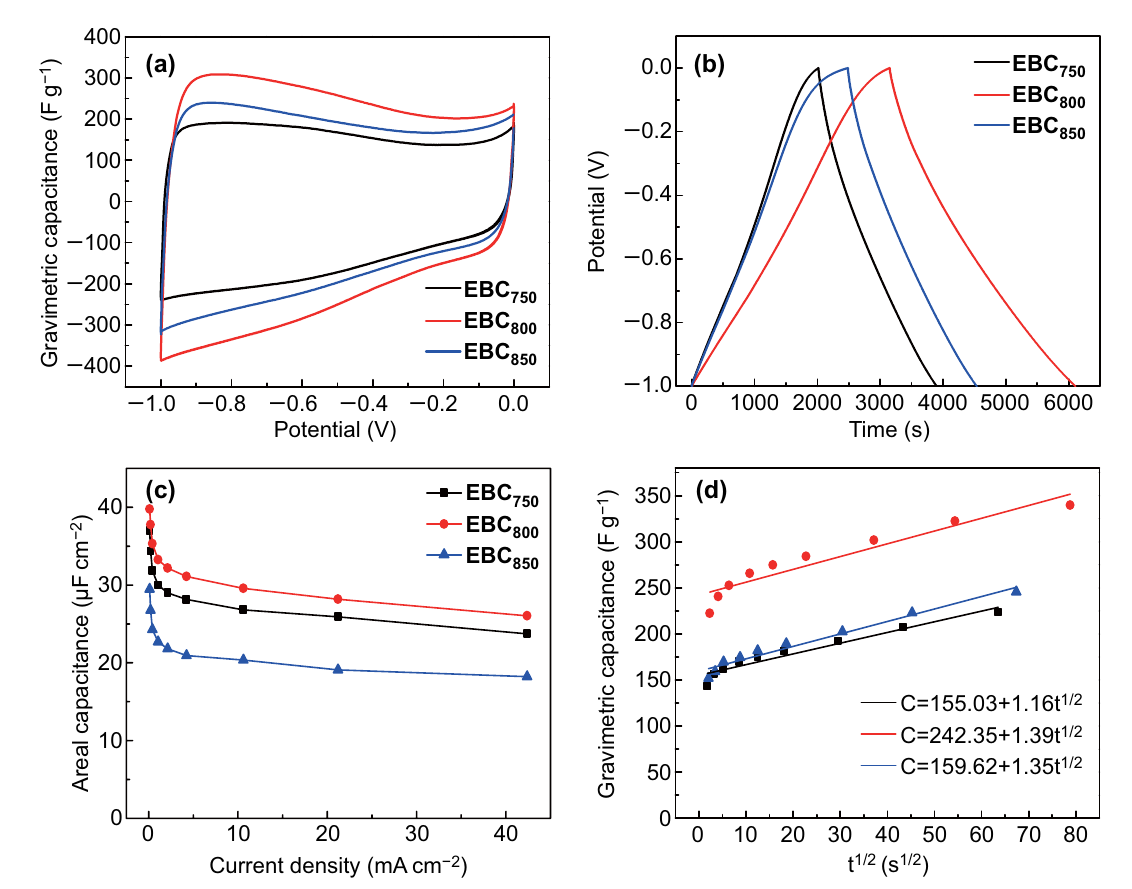
Fig. 5 Electrochemical performance of EBC electrodes in a three-electrode system in 6 M KOH electrolyte: a CV profiles at 5 mV s −1 , b GCD curves at 0.212 mA cm −2 , c areal capacitance at various current densities, and d gravimetric capacitance versus t